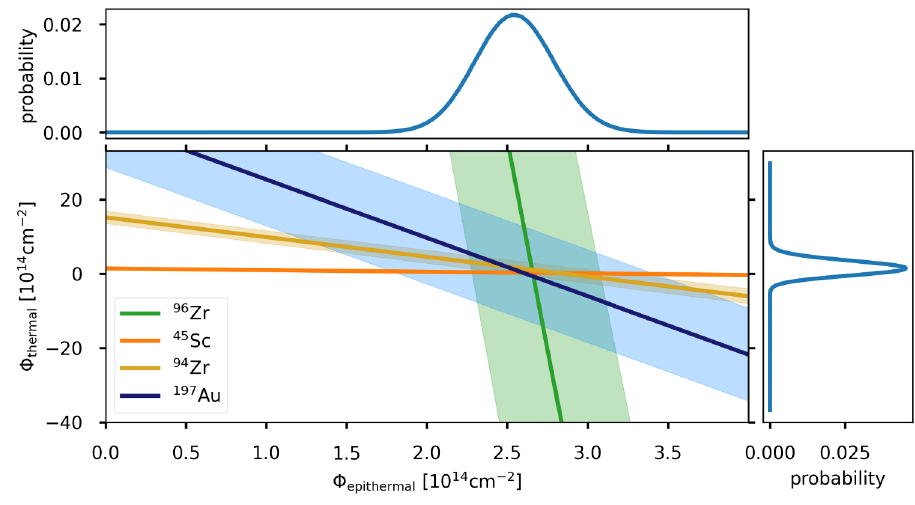
Figure 2. Relation between the thermal Φ th the epithermal neutron flux Φ epi determined by four moni- tors. The shared axes show projections of the probability distribution.